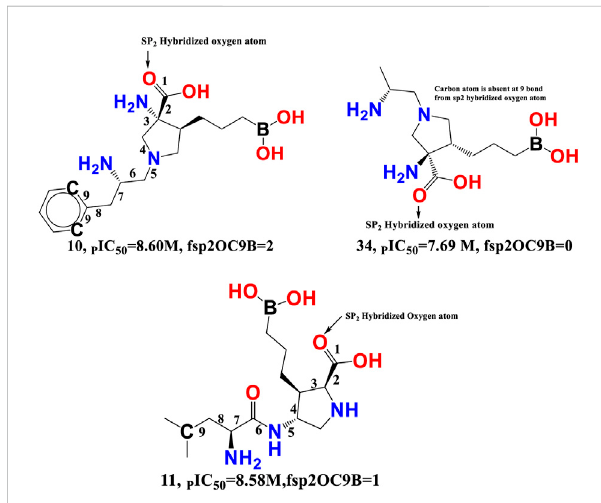
FIGURE 7 Illustration of the molecular descriptor fsp2OC9B for